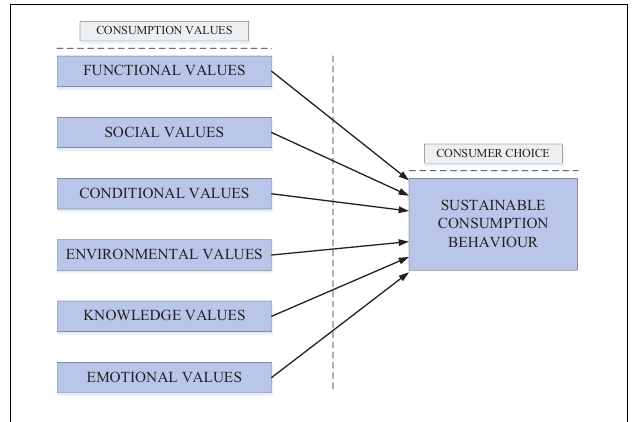
FIGURE 1 | Study framework.